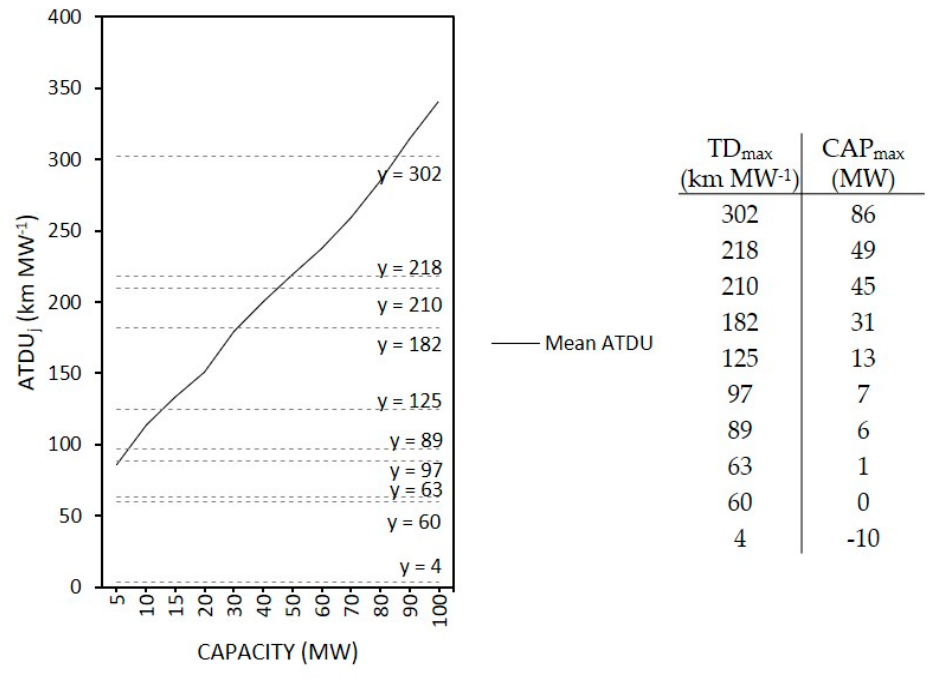
Figure 5. Comparison between mean ATDU j and TD max of different price-cost scenarios. Table 4. Percentage of strategic locations performing under the respective TD max scenarios over a range of different capacities.